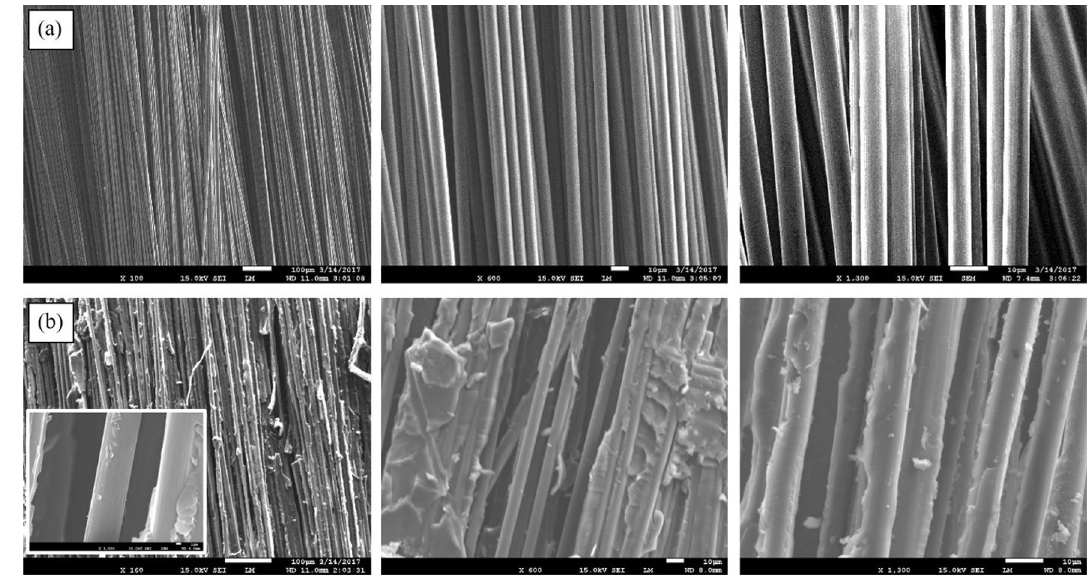
Figure 2. SEM images of ( a ) virgin and ( b ) recycled carbon